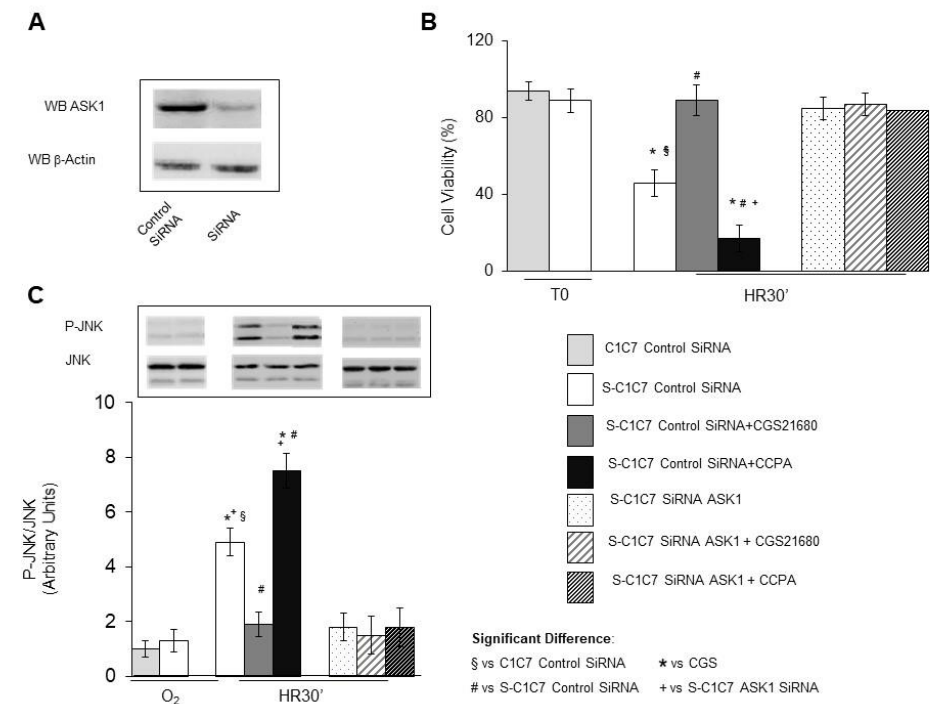
Figure 2. Effects of A2AR and A1AR pharmacological stimulation on HR injury and ASK1/JNK activation of steatotic C1C7 cells with downregulated expression of ASK1. Steatotic (PA 700 µ M, S-C1C7) and non steatotic C1C7 cells (C1C7) transfected with control SiRNA or ASK1 SiRNA and pre-exposed or not to the A2AR agonist CGS21680 (5 µM) or to the A1R agonist CCPA (100 µM), were stored at 4 °C for 8 h in hypoxic conditions in in presence (S-C1C7) or absence (C1C7) of palmitic acid (PA, 700 μM) and reoxygenated at 37 °C for 30 min (HR30′). ( A ) WB analysis of ASK1 expression after C1C7 cells transfection with Control SiRNA or ASK1 SiRNA (SiRNA); ( B ) Cell viability; ( C ) JNK activation. The different parameters were estimated after normoxic incubation (O2), and/or at the end of hypoxic storage (T0), or after 30 min of reoxygenation (HR). The results represent the mean of 3 experiments ± SD. Statistical significance: * # § p < 0.05.